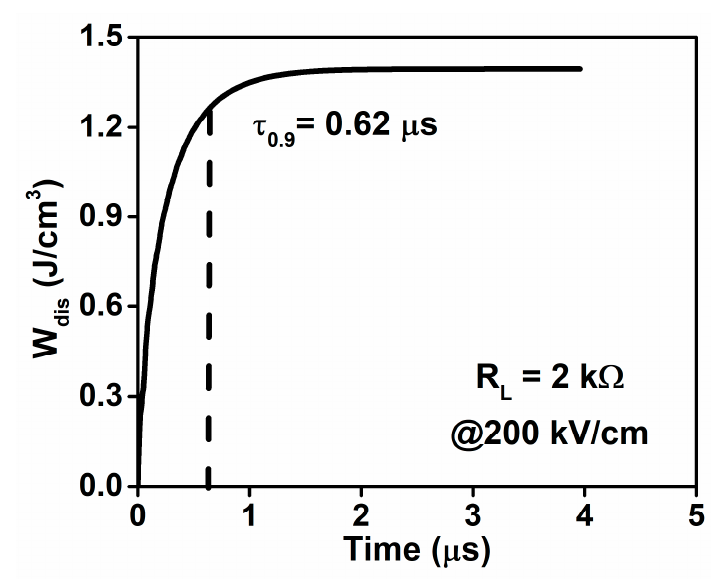
Figure 8. Discharge energy density as a function of time for 6BMZ ceramic at 200 kV / cm and ambient temperature.